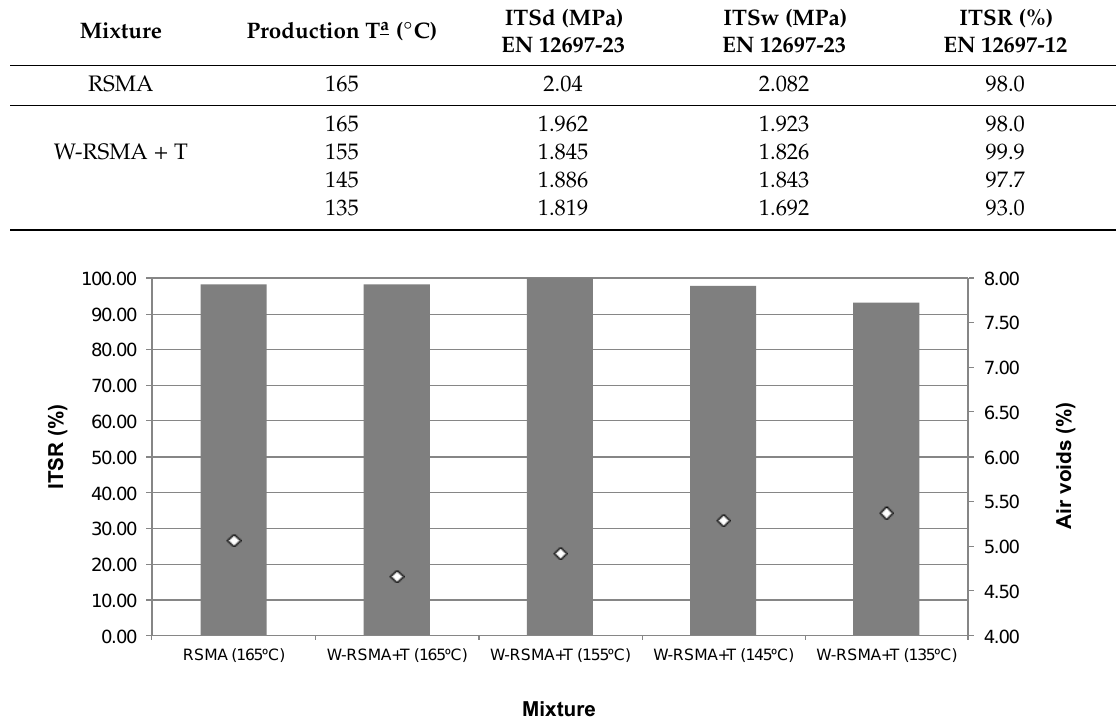
Figure 5. ITSR results for samples prepared with the gyratory compactor.